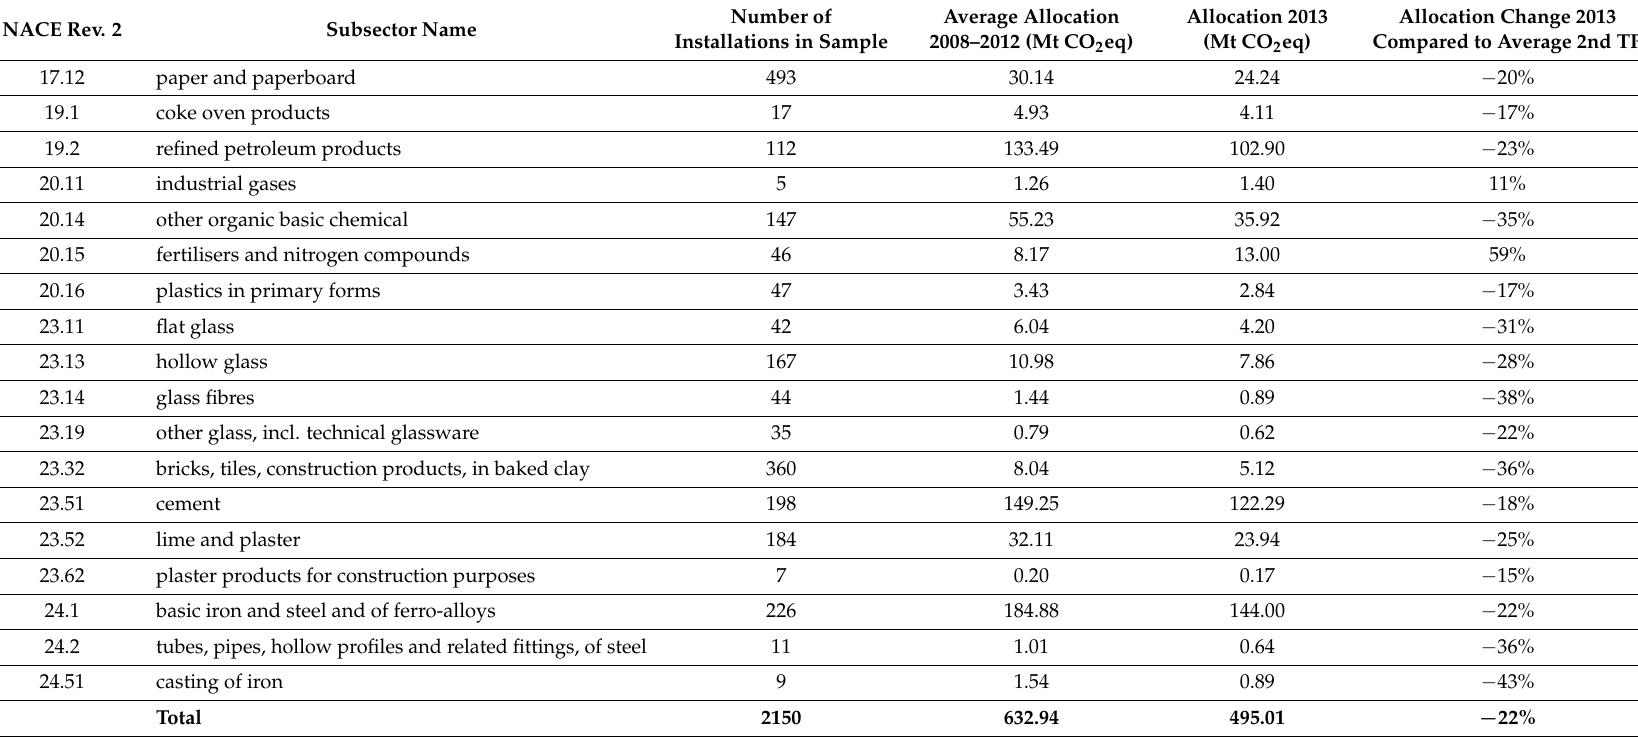
Table 1. Sample size and distribution of the average allocation change in 2013 compared to the average of the 2nd Trading Period (TP) by NACE